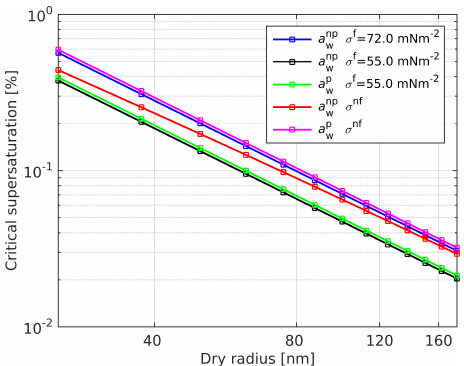
Figure 1. Critical supersaturation S c as a function of dry radius r d for all partitioning schemes. a p w and a np w labels, respectively, indi- cate whether the partitioning effects are or are not accounted for in the water activity term a w ; σ f and σ nf indicate whether the sur- face tension is prescribed a fixed value or modelled using Eq. (9). Particles are internal mixtures of NaCl and SRFA with organic- to-inorganic ratio α = 2. Complete solubility and ideality are as- sumed. The partitioning parameters used for SRFA are (cid:48) = 0 . 0025 and K =